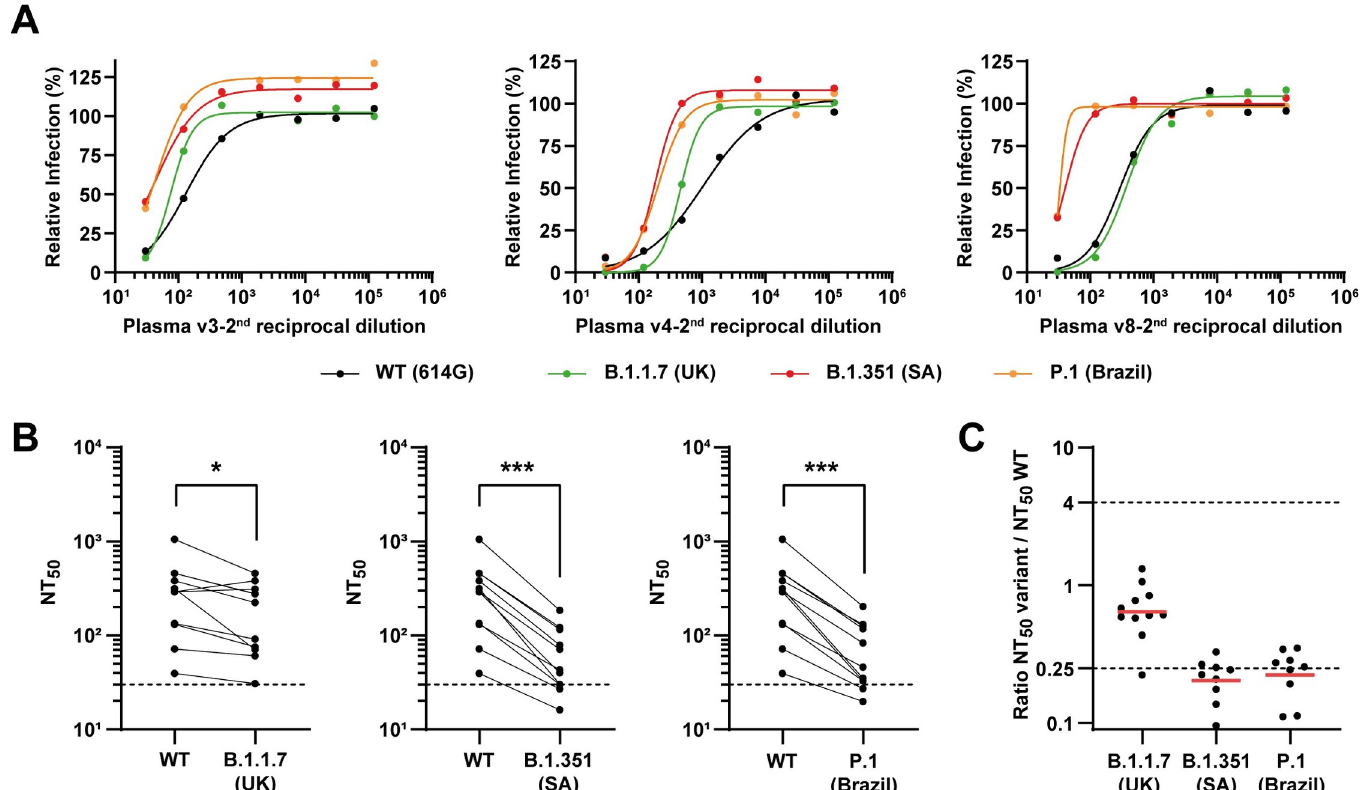
Fig 3. Neutralization of SARS-CoV-2 variants of concern by post-vaccination plasma. Neutralization assays were performed with pseudoviruses displaying WT SARS-CoV-2 spike or variants of concern B.1.1.7, B.1.351 and P.1, in the presence of serial dilutions of post-vaccination plasmas from 10 individuals, 12 days after the first and the second rounds of vaccination. (A) Representative neutralization curves of post-vaccination plasma against WT virus and variants of concern. (B) Paired analysis of neutralizing activity each of plasma against WT vs variants of concern. Dashed lines indicate the limit of detection of the assay (NT 50 = 30). � p < 0.05, ��� p < 0.001 by two-tailed Wilcoxon matched-pairs signed-rank test. (C) Ratios of neutralization between variant and WT viruses. Red bars indicate the geometric mean. See S6 Fig and S3 Table for the complete set of neutralizing curves, the anti-spike IgG titers of each plasma and the numerical values plotted in this figure.